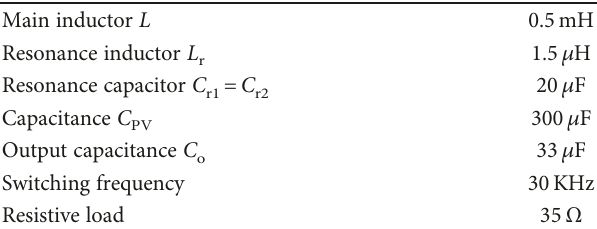
Figure 6: Waveforms of inductor voltage and capacitor current. Table 2: Isolated Ć uk converter